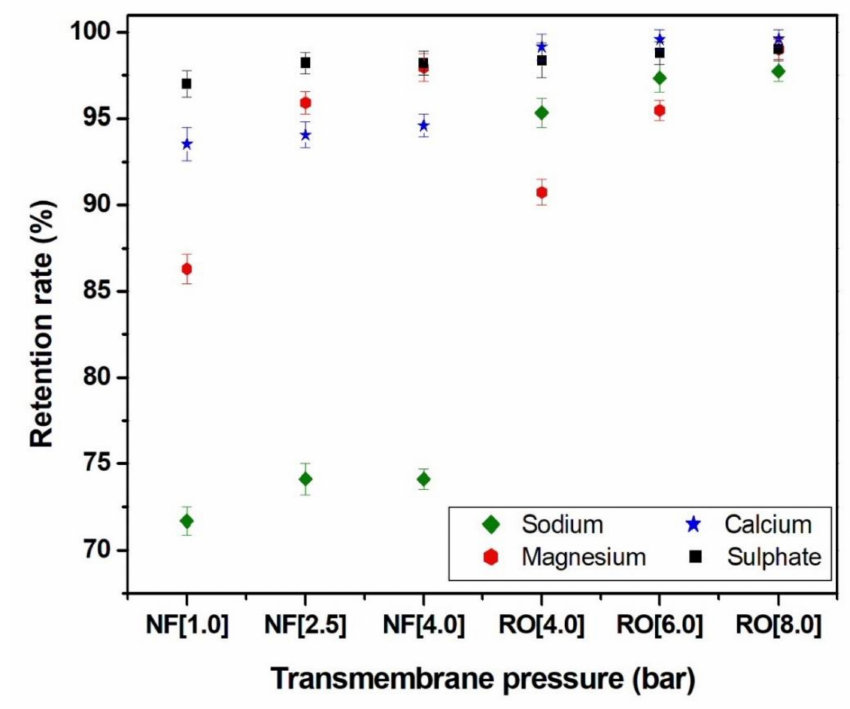
Figure 3. Ion rejection rates for the NF270 and TW30 membranes used. In reverse osmosis, the pressures applied allowed significant removal of sulphate ions. The results for reverse osmosis were optimum for the applied pressure of 8 bar. This optimum corresponded to a conversion rate of 55.8% and rejection rates of 99.0% for sulphate ions, 99.5% for calcium ions, 95.1% for magnesium ions and 97.3 for sodium ions. 98.4% and 99.0%. In addition, it was found that for all the solutions studied, increasing the feed pressure from 4 to 8 bar resulted in an improvement in the sulphate rejection